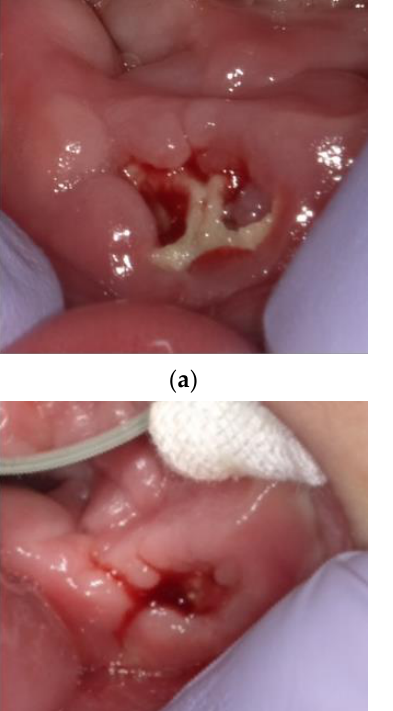
Figure 7. Extra- and intraoral photographs acquired at the age of 6 years and 5 months: ( a ) mandib- ular, ( b ) left side of face, ( c ) mandibular, ( d ) mandibular right region, and ( e ) mandibular left region. 3. Discussion Osteopetrosis is accompanied by many oral problems: delayed or failed tooth erup- tion, the absence of some teeth, tooth malformation, enamel and dentinal hypominerali- zation, periodontal membrane defects, and thickened lamina dura [4 – 10]. Delayed or failed tooth eruption is caused by an increasingly insufficient supply of nutrients to the developing tooth germ, which results from increased bone density [9 – 12]. Our patient ex- hibited this finding: only four primary central incisors erupted within 1 year after birth. A tooth eruption might have been possible before the progression of osteosclerosis. How- ever, the fenestration and protrusion of impacted teeth are difficult for patients with oste- opetrosis, in whom eruption cannot be expected because of ankylosis in the cementum interface along with the lack of an alveolar ligament [12]. Surgical management is accom- panied by high risks of osteomyelitis and bone fractures [2,6 – 11]. Dentures are fabricated for patients with osteopetrosis who exhibit multiple impacted teeth [7,13,14]. Such fabri- cation could not be performed for our patient because of his severe mental retardation. Frequent denture adjustment is recommended to prevent the development of ulcers un- der dentures [7]. Osteomyelitis in patients with osteopetrosis can be caused by infections that occur after tooth extraction [12,15 – 17]. Osteomyelitis can also be caused by impaired alveolar socket repair after delayed wound healing because of reduced blood supply to the jaw [2,4 – 10]. When surgical interventions are performed, antibiotic prophylaxis is rec- ommended to prevent infection and osteomyelitis related to the reduced periosteal blood supply [6,8]. There have been two reports concerning the spontaneous exfoliation of primary teeth in a patient with osteopetrosis [13,18]. In one patient, this phenomenon was caused by poor fibrous attachment [13]. After the exfoliation of a primary incisor, a tooth-like struc- ture emerged into the oral cavity in our patient. The underdeveloped dental papilla cells and underdevelop ed Hertwig’s root sheath might easily become detached from the calci- fied portion of a tooth and remain in the alveolus, subsequently developing into a tooth- like structure that erupts months or years later [19]. Histopathological analysis was